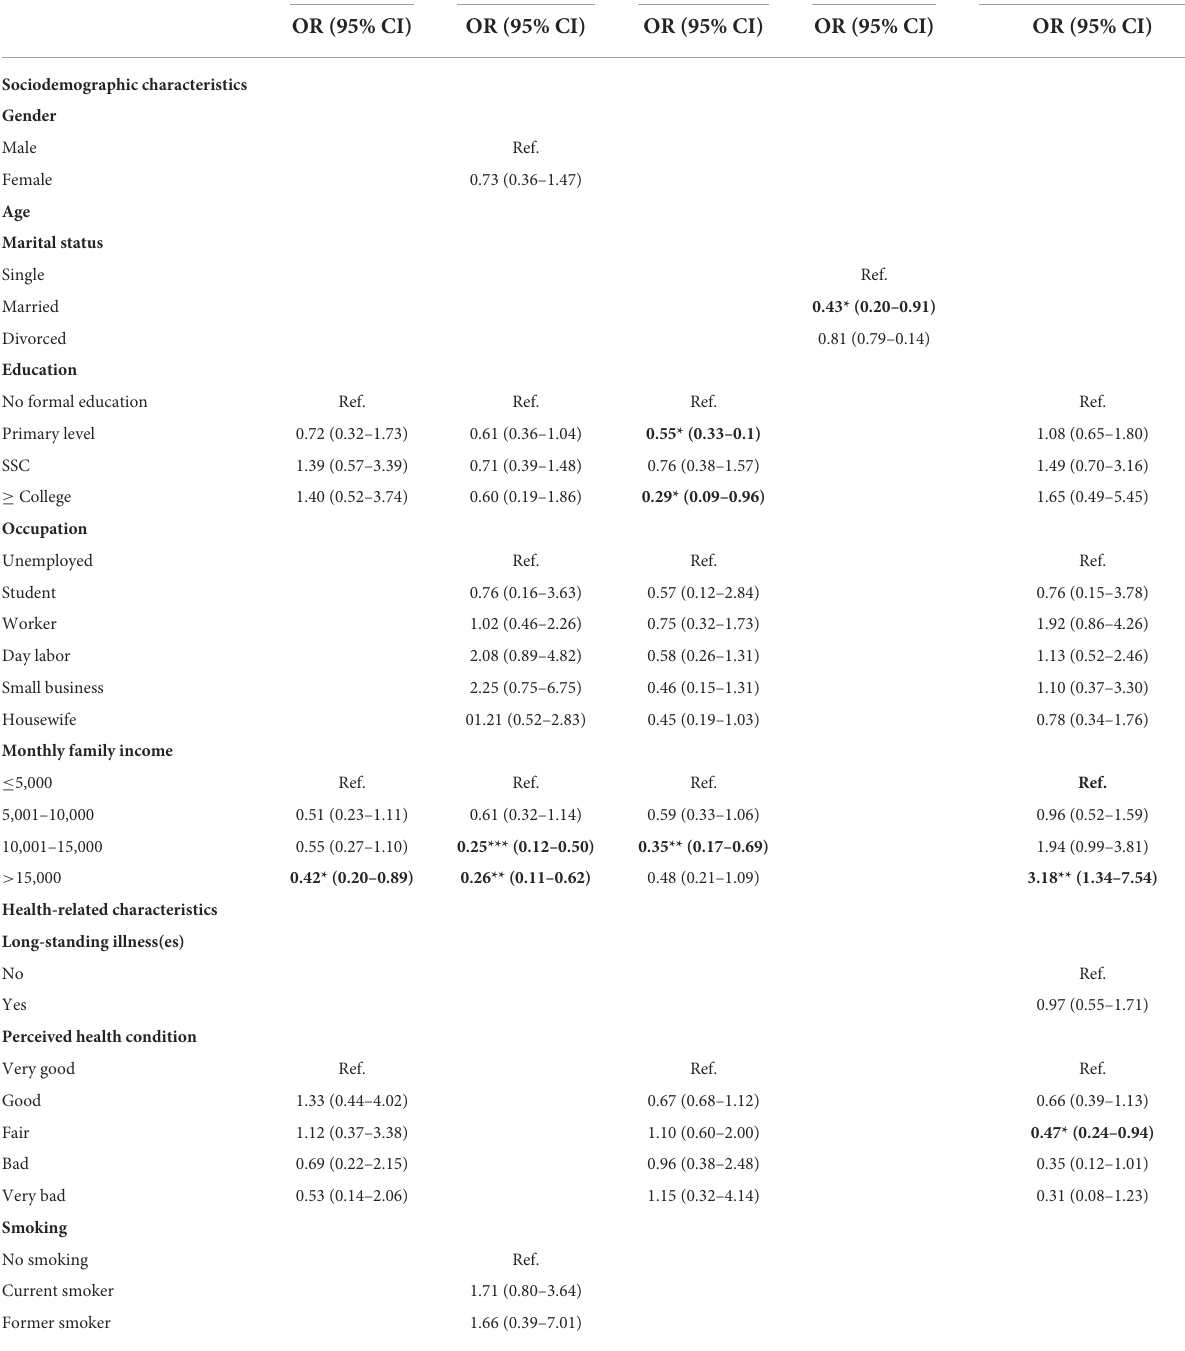
TABLE 3 Factors affecting the psychological antecedents ( N =